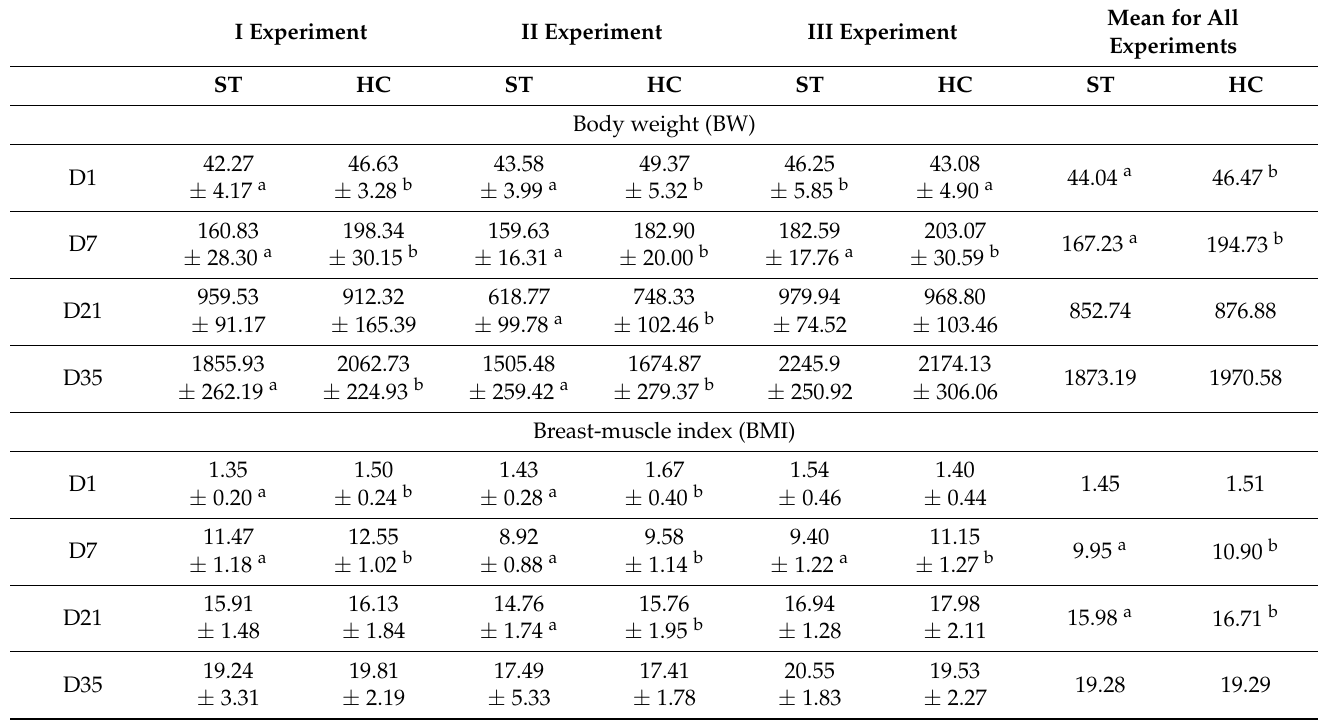
Table 2. Body weight and breast-muscle index of standard broilers (ST) and HatchCare broilers